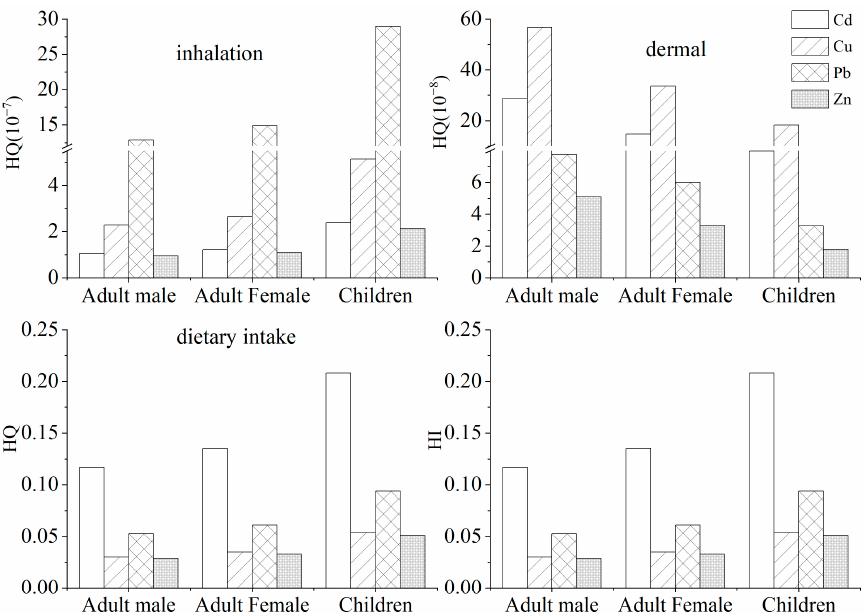
Figure 4. Noncarcinogenic risks of heavy metals through three exposure pathways.